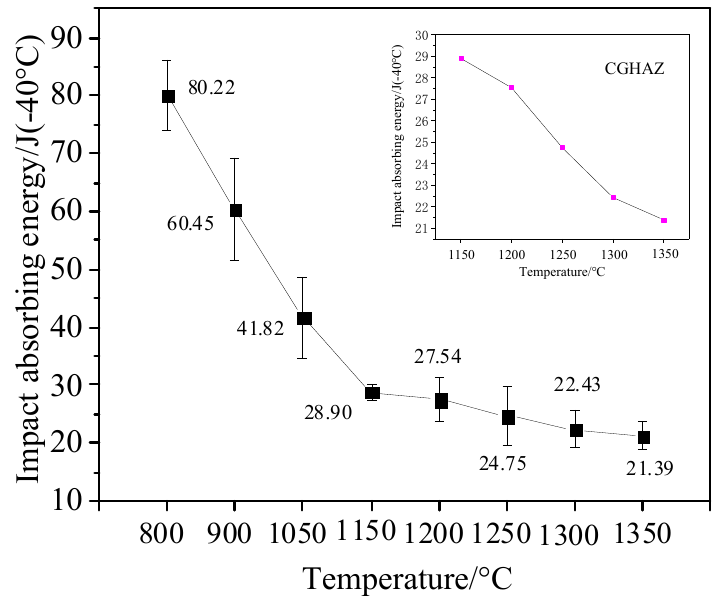
Figure 9. Impact toughness of simulated HAZ at different peak temperatures.